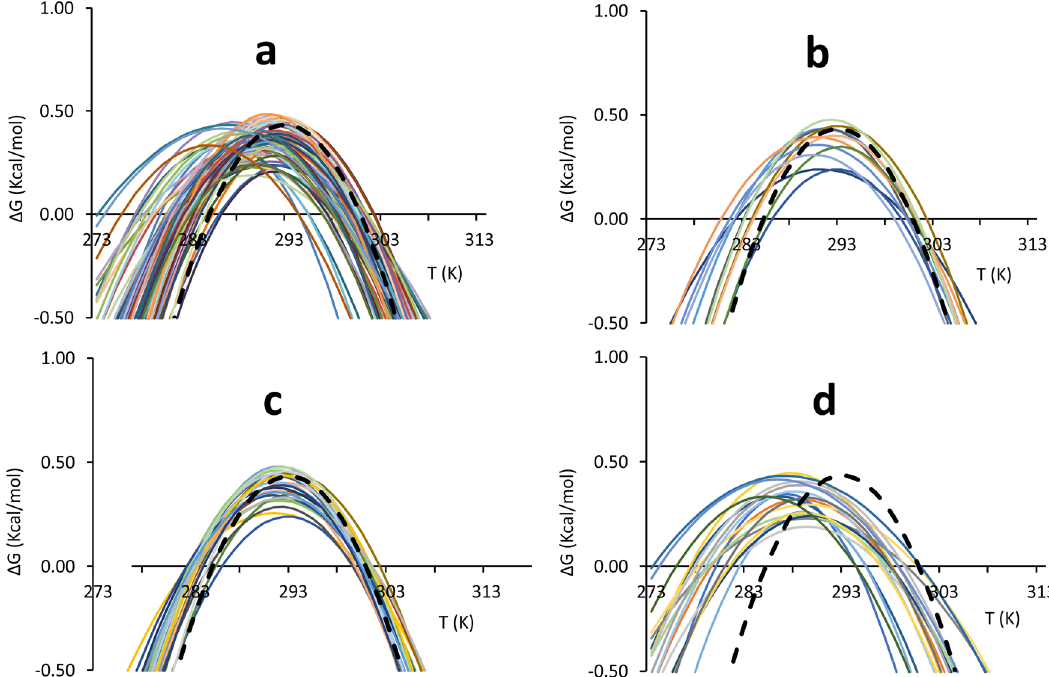
Fig. 1 Comparison of single residue stability curves with the global RAD_0.1 best curve. Individual curves are indicated with different colours, the global RAD_0.1 curve is indicated by a dashed black line. a Stability curves of all observable isolated residues. b Stability curves of residues with a RAD <0.1. c Stability curves of single residues for which the difference in the unfolding temperatures with respect to values of the reference curve ( Δ T m and Δ T c ) is on average below 1.5 °C d Stability curves of single residues for which the difference in the unfolding temperatures with respect to values of the average curve ( Δ T m and Δ T c ) is on average above 3 K. The colour coding is de fi ned in Supplementary Table S1. Note that for simplicity, colour coding was automatically set by the excel software and is not the same in the different panels.